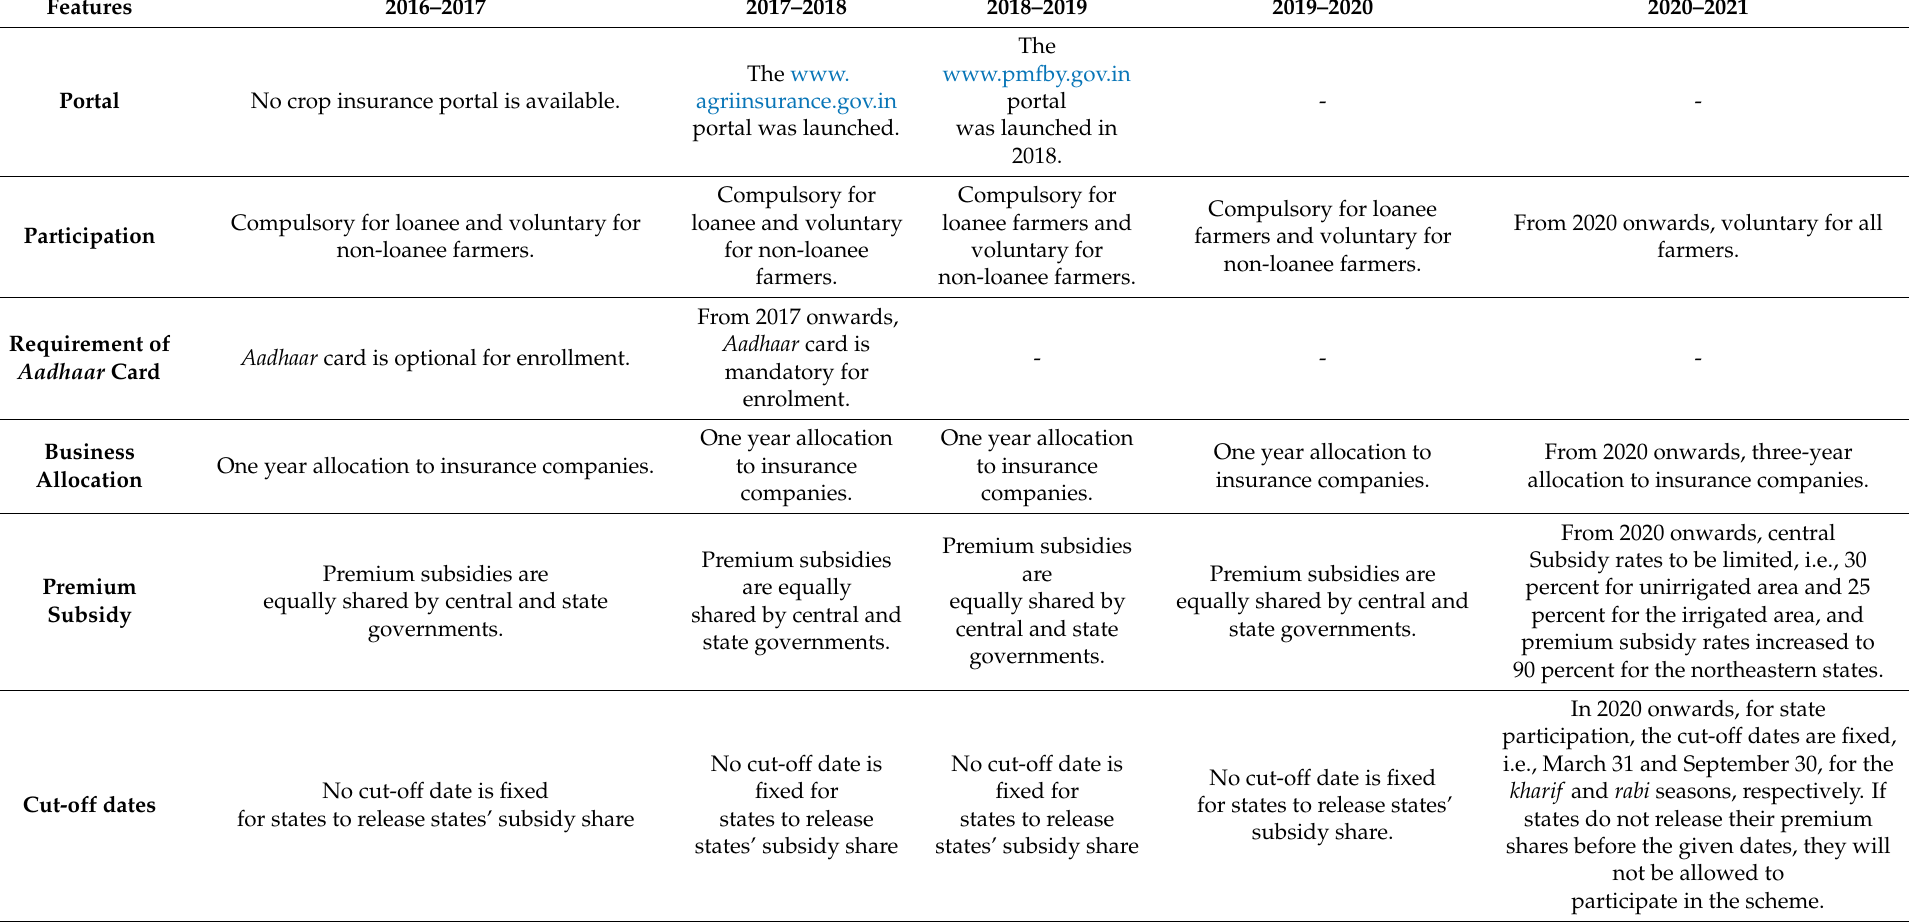
Table 2. Salient changes made under PMFBY from 2016–2017 to